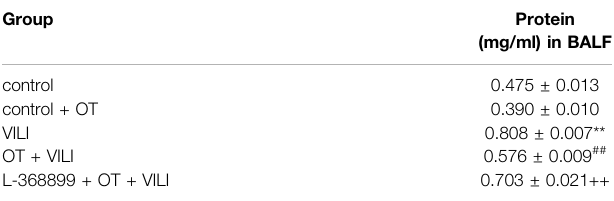
TABLE 2 | Effects of Oxytocin on protein permeability in BALF.